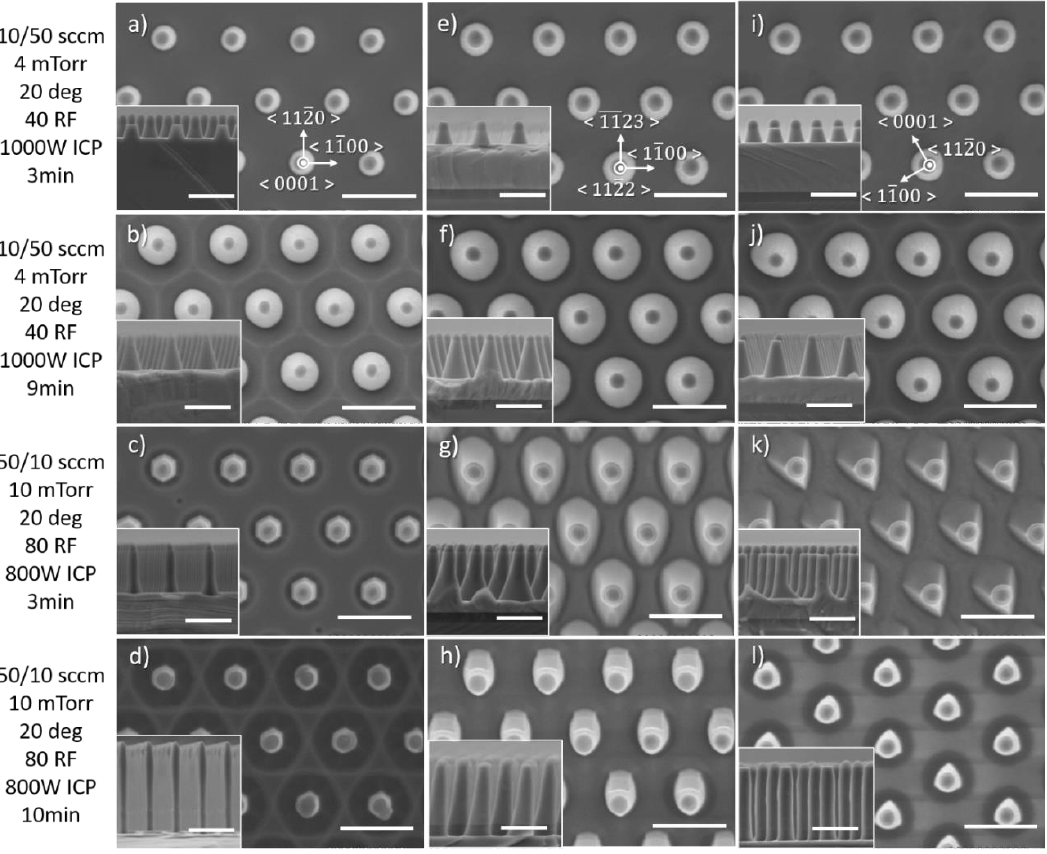
Figure 13. Plan view and cross-sectional (inset) SEM image of GaN nanorod etch series 7 and 8 with different times for two etching conditions, for ( a – d ) c -plane ( e – h ) (11 2̅2 ) semi-polar and ( i – l ) (11 2̅0 ) non-polar GaN layers. Scale bar is 1 µm.